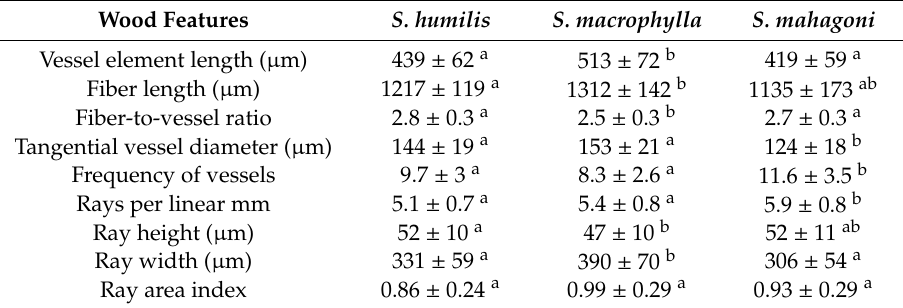
Table 2. Mean values and standard deviations with t -tests for the nine measured and calculated indices in three Swietenia